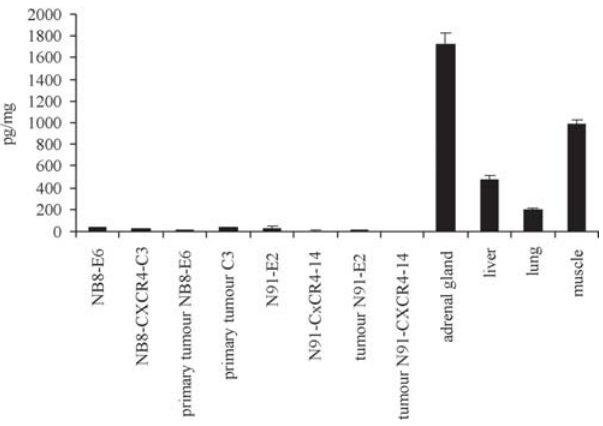
Figure 5. CXCL12 production in mouse tissues and NB tumours. The production of CXCL12 was measured by ELISA in normal mouse tissues, as well as in the different clones, and primary tumours. Results of triplicates are expressed as pg of CXCL12 per mg of extracted protein. One representative of three independent experiment is shown. Experiments were performed in